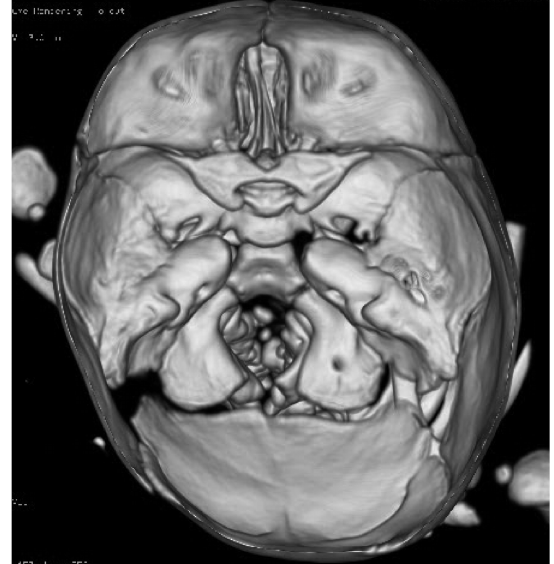
Figure 2 - 3D reconstruction CT scan of a-3-year old male patient with SCD showed skull base asymmetry associated with significant endocranial synchondrosis and defective ossification. The asym- metry is more marked in the middle and the posterior cranial fossa while the anterior cranial fossa is slightly asymmetric.